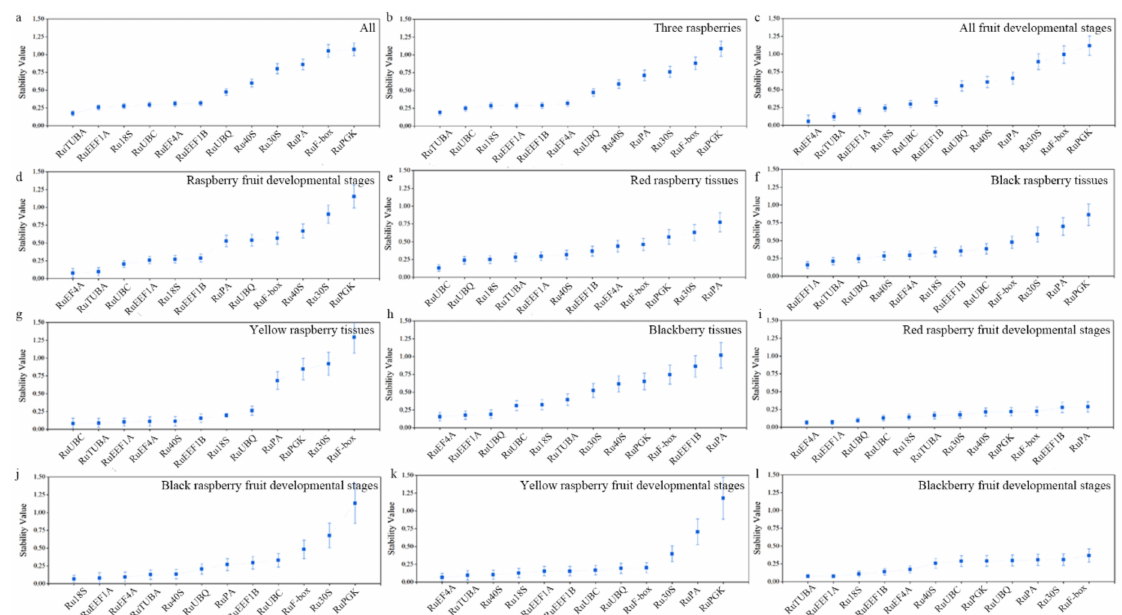
Figure 4. Gene expression stability of 12 candidate reference genes using NormFinder analysis. The lower the stability value, the more stable the expression level. ( a ) All 72 samples; ( b ) Three raspberries; ( c ) All fruit developmental stages; ( d ) Raspberry fruit developmental stages; ( e ) Red raspberry tissues; ( f ) Black raspberry tissues; ( g ) Yellow raspberry tissues; ( h ) Blackberry tissues; ( i ) Red raspberry fruit developmental stages; ( j ) Black raspberry fruit developmental stages; ( k ) Yellow raspberry fruit developmental stages; ( l ) Blackberry fruit developmental